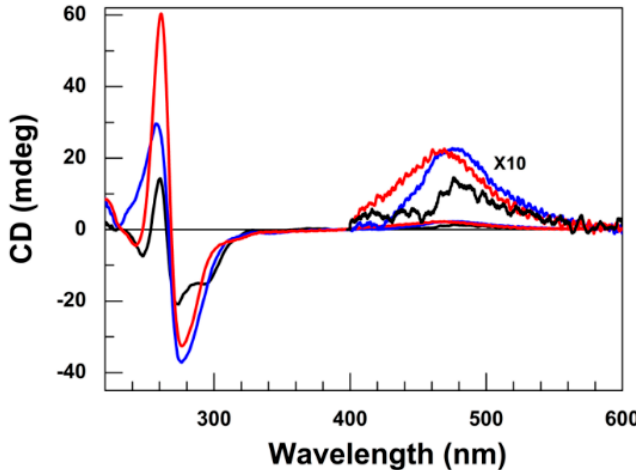
Figure 2. CD spectra of bis ‐ Ru ‐ bpp in the presence of poly[d(A ‐ T) 2 ] (red curve), poly[d(G ‐ C) 2 ] (black curve) and poly[d(I ‐ C) 2 ] (blue curve). The spectra enlarged 10 times shown at long wavelength for ease of comparison. The concentration is the same in Figure 1.